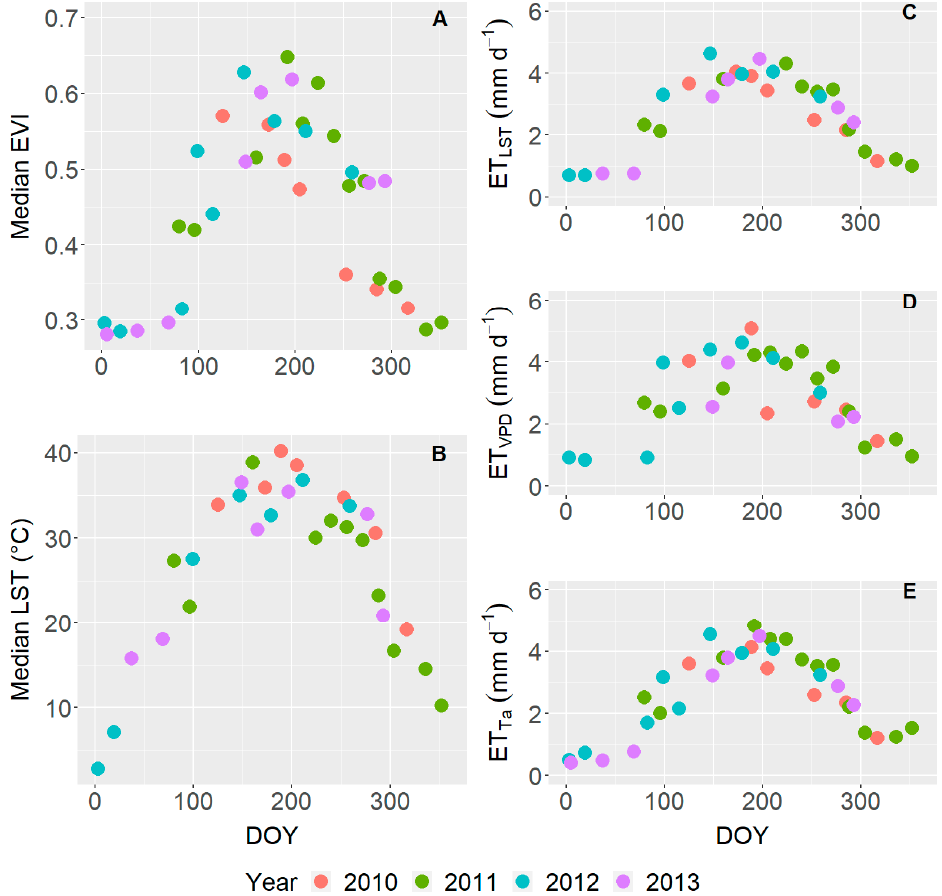
Figure 5. Median EVI ( A ) and LST ( B ) within the EC footprint derived from Landsat imagery, and modeled daily vineyard ET as calculated with EVI and LST ( C ), VPD ( D ), and Ta ( E ), respectively.